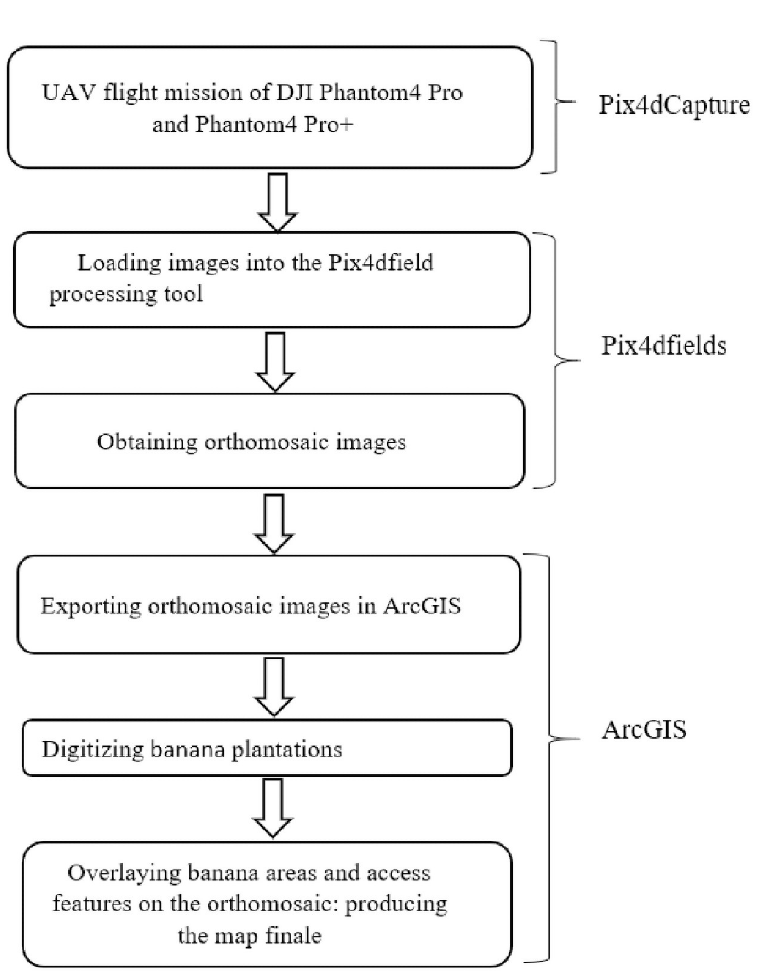
Fig 2. Summary of the study analysis workflow for image processing in Pix4Dfields and ArcGIS. mission. A safety margin of 10 minutes of flight representing 30% of battery power was left for safe landing and take-off manoeuvrers.